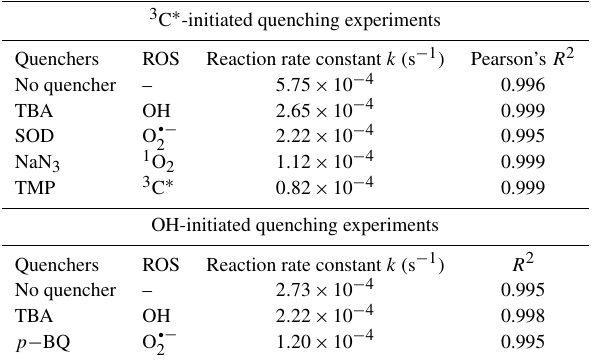
Table 1. The first-order rate constants of eugenol in the presence of various scavengers. The initial conditions were as follows: 300µM eugenol, molar ratios of eugenol to quenchers TBA, NaN 3 , TMP, and SOD of 1.5, 0.15, 0.075, and 2.5, respectively, molar ratios of eugenol to quenchers pBQ and TBA of 0.8 and 0.75,